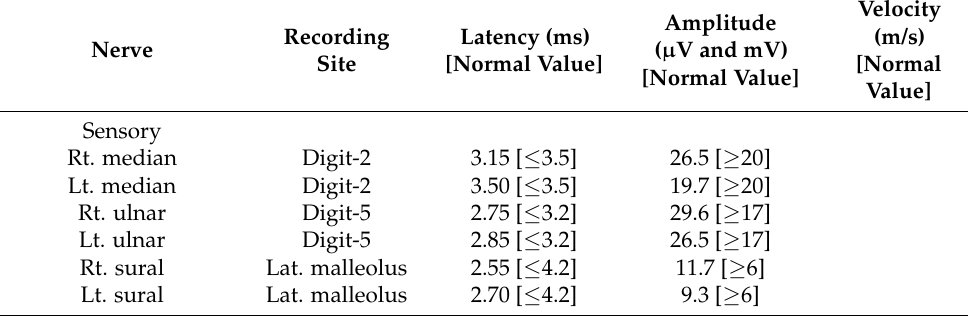
Table 1. Nerve conduction study results at